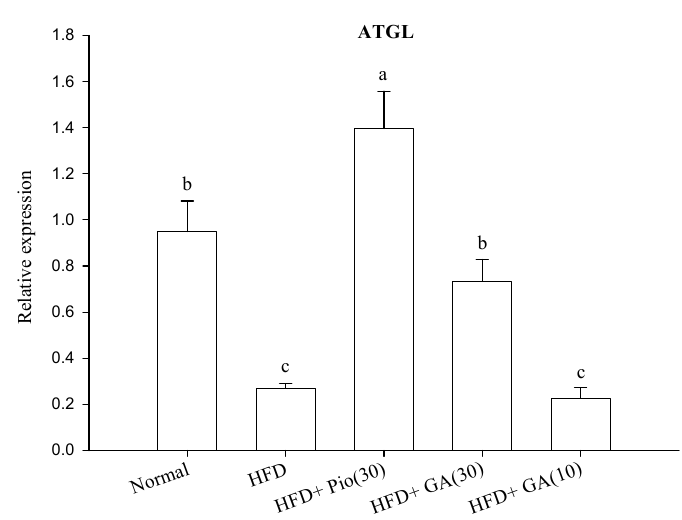
Figure 3. Effect of GA on the expression of carbohydrate ( A ) and lipid ( B ) metabolism-related proteins in adipose tissue of HFD rats. GA: gallic acid; PFK: phosphofructokinase; PK: pyruvate kinase; ATGL: adipose triglyceride lipase; Normal: rats fed a normal diet; HFD: rats fed a 66% fructose diet; HFD + Pio (30): rats fed a 66% fructose diet and orally administered pioglitazone (30 mg/kg body weight); HFD + GA (30): rats fed a 66% fructose diet and orally administered GA (30 mg/kg body weight); HFD + GA (10): rats fed a 66% fructose diet and orally administered GA (10 mg/kg body weight). Different letters (a–c) indicate a significant difference at p < 0.05. Values calculated as the means ± SD for six rats in each group. The relative expressions of PFK, PK, and ATGL in each treatment group were calculated using α -tublin as the standard.